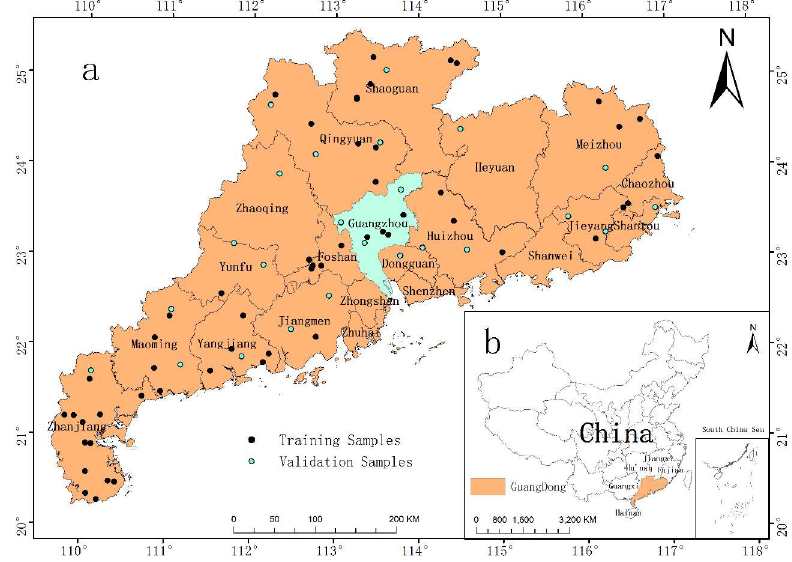
Figure 1. ( a ) The study area with the spatial distribution of 65 training and 15 validation soil samples, and Guangzhou city highlighted in cyan; and ( b ) its location in China.